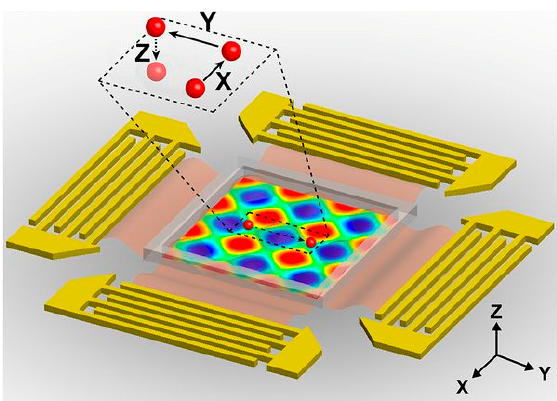
Figure 15 . Schematic representation of 3D acoustic tweezers showing particle trapping. The solid arrows represent the movement of cell in X, Y and Z direction. The dotted arrows show an enlarged view of cell location on chip. Permission to reprint obtained from PNAS [74] .